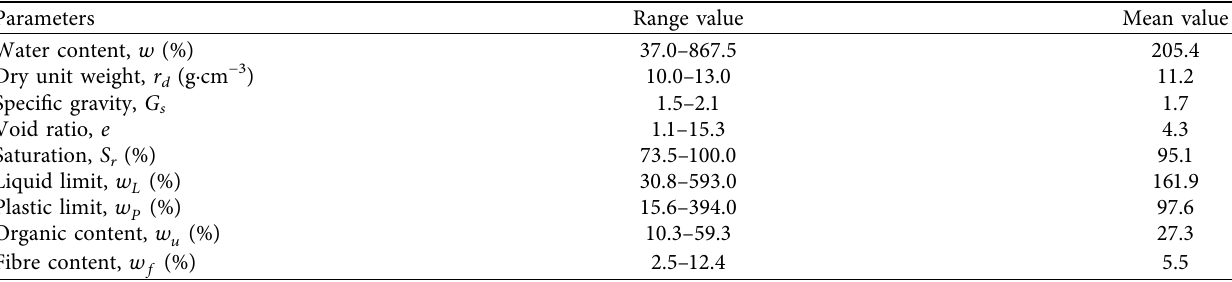
Figure 2: (a) View of expressway during construction. (b) View of expressway taken two years after construction. Table 1: Physical properties of peat soils.